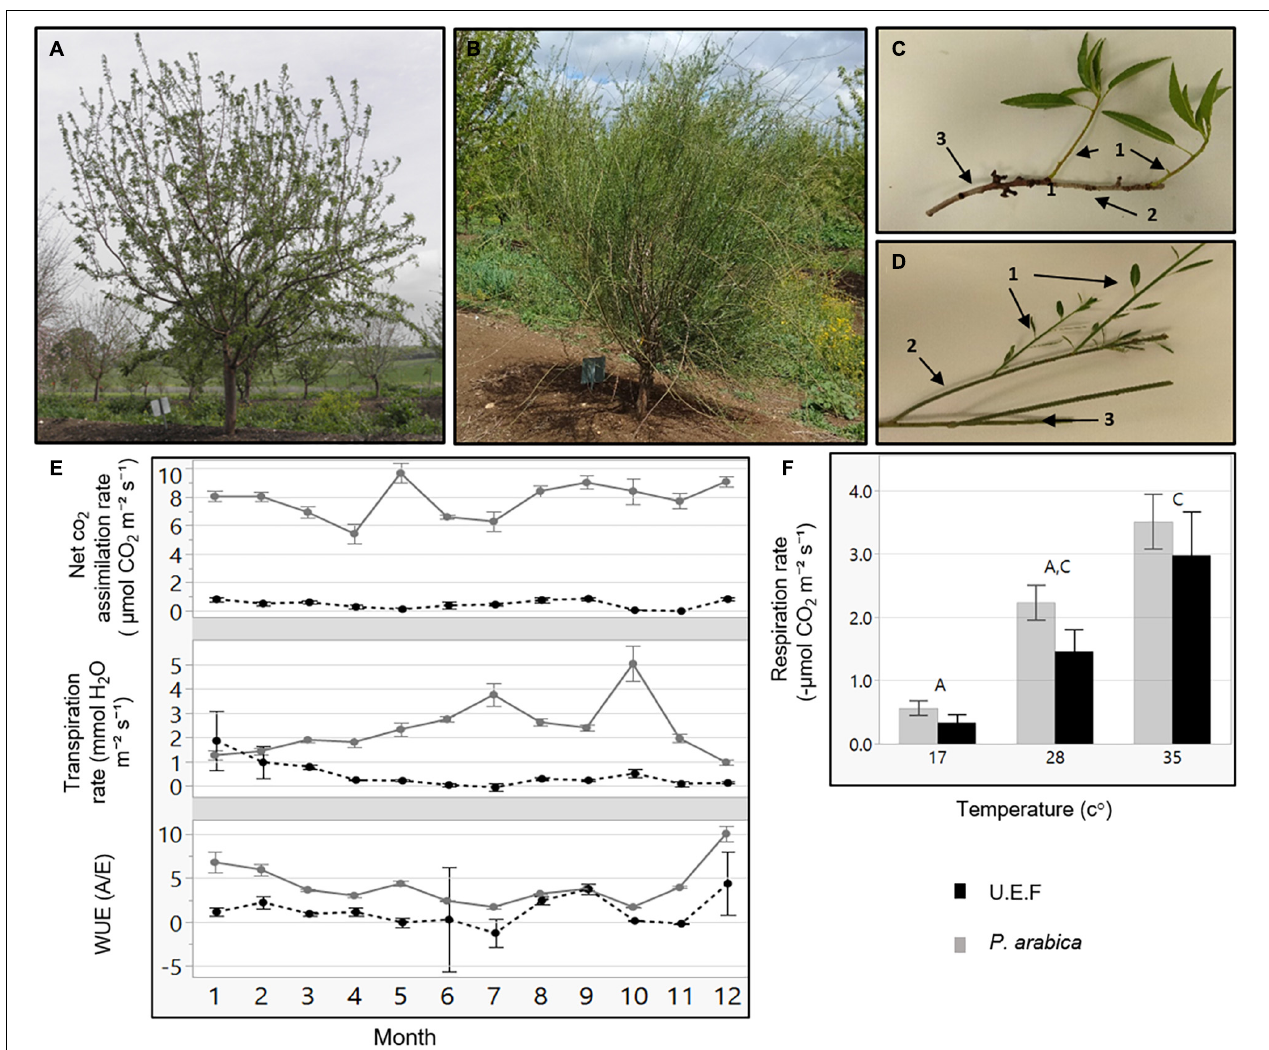
FIGURE 1 | Gas exchange measurements of P. arabica and Prunus dulcis cv. Um el Fachem (U.E.F.) stems. Three-year-old trees of the Israeli cultivar Prunus dulcis cv. U.E.F. (A) , and the wild almond P. arabica (B) at spring. Stems of U.E.F. (C) , and P. arabica (D) annually developed: 1-year-old (c1 and d1), 2-year (c2 and d2), and 3-year-old stems (c3 and d3). Gas exchange data of 1-year-old stems along the year (E) of P. arabica (solid gray line), and U.E.F. (dashed black line). Each dot denotes the average of two independent days of measuring for each month ( n = 8). Stem respiration rate in response to three different temperatures (F) of P. arabica (gray bar) and U.E.F. (black bar). Four stems were measured for each genotype in each temperature ( n = 4). Different capital letter represents significance ( α = 0.05) between temperatures, not between species. The error bars represent ± SE.